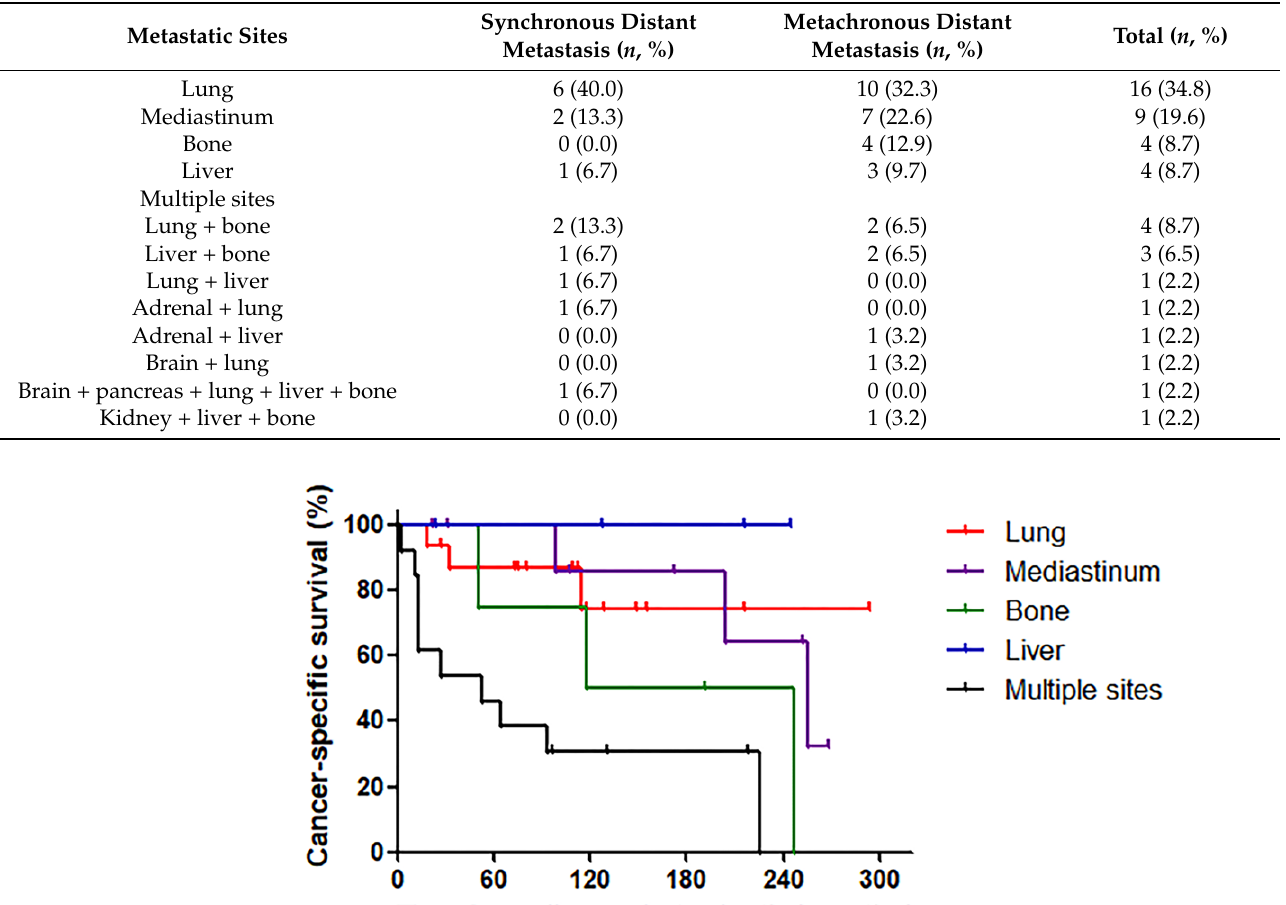
Table 3. Comparison of metastatic sites between synchronous distant metastasis and metachronous distant metastasis groups.